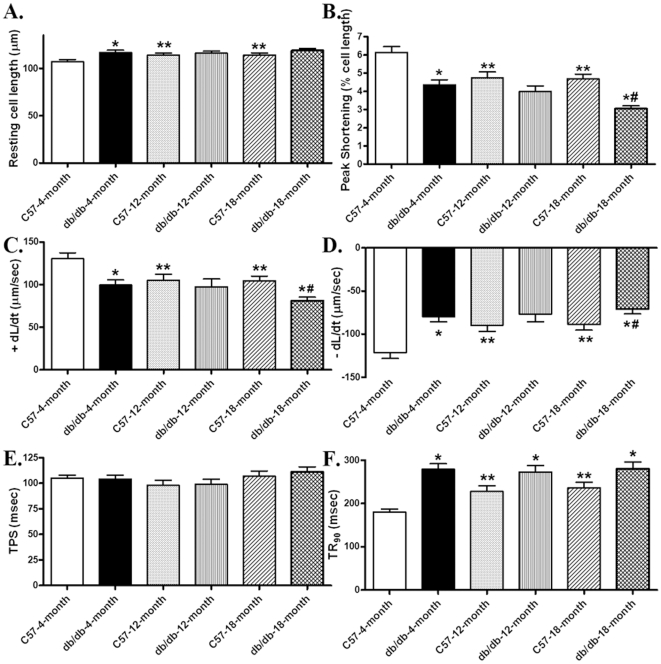
Contractile properties of cardiomyocytes isolated from young
(4-month-old) and aging (12- or 18-month-old) male C57 lean and the
leptin receptor-deficient db/db obese mice.A: Resting cell length; B: Peak shortening (PS, normalized to cell
length); C: Maximal velocity of shortening (+ dL/dt); D:
Maximal velocity of relengthening (- dL/dt); E: Time-to-peak shortening
(TPS); F: Time-to-90% relengthening (TR90); Mean
± SEM, n = 102–103
cells from 3 mice per group, * p<0.05
vs. respective C57 group, **
p<0.05 vs. young C57 (4-month) group, #
p<0.05 vs. young db/db
(4-month) group.